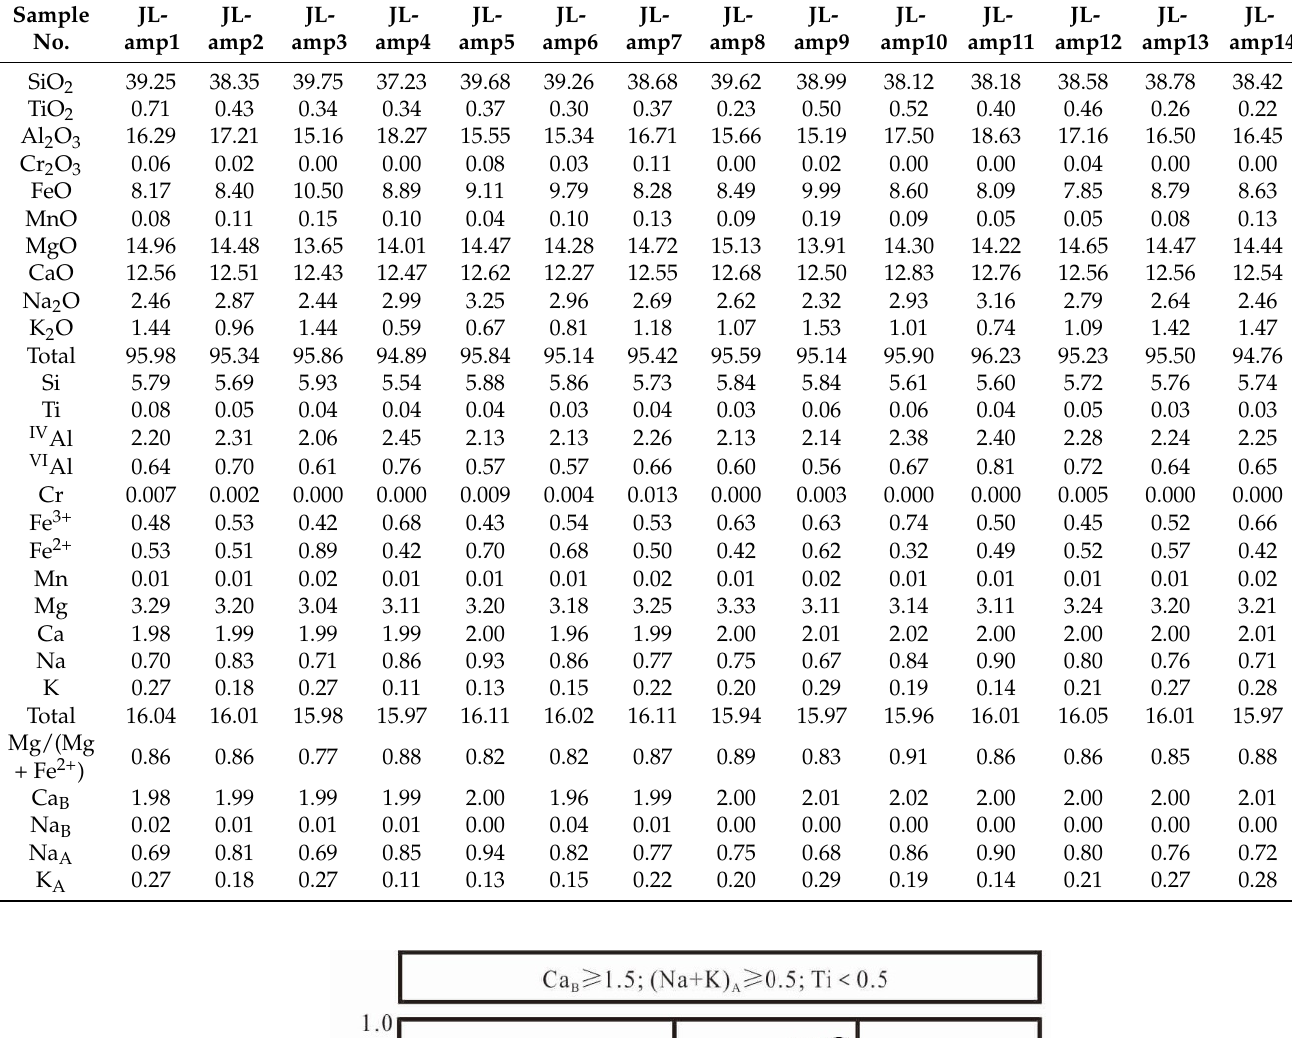
Table 4. EPMA data for amphiboles from Jinling skarn and ore.